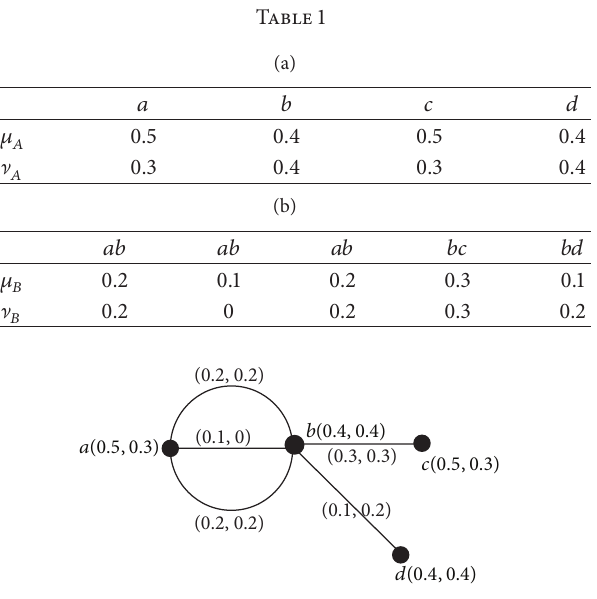
Figure 1: Intuitionistic fuzzy